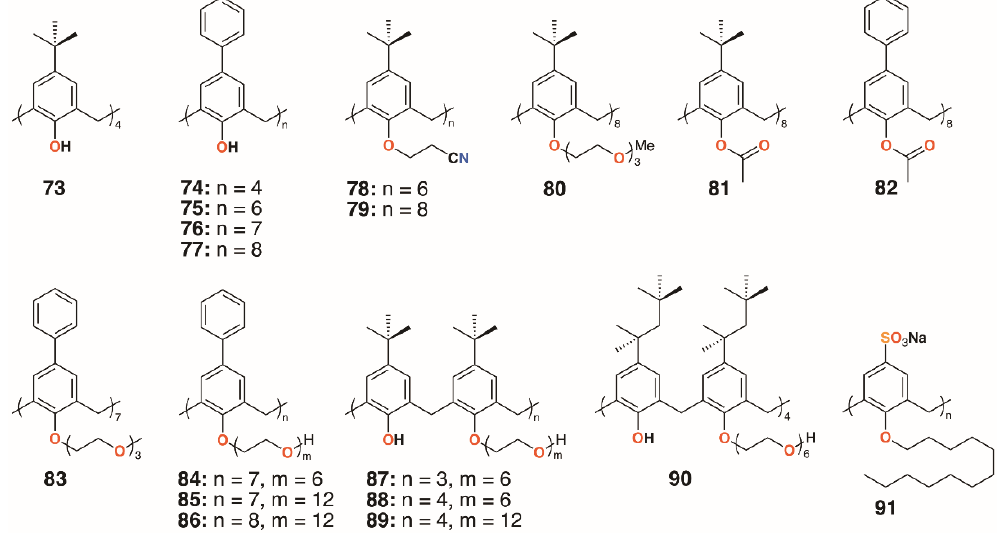
Figure 14. Hailes’ Macrocyclon analogues.